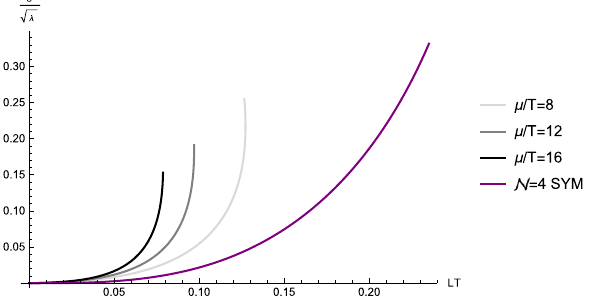
√ λ versus LT in different values of μ/ T at θ = 2 and Fig. 5 S / z = 2 .